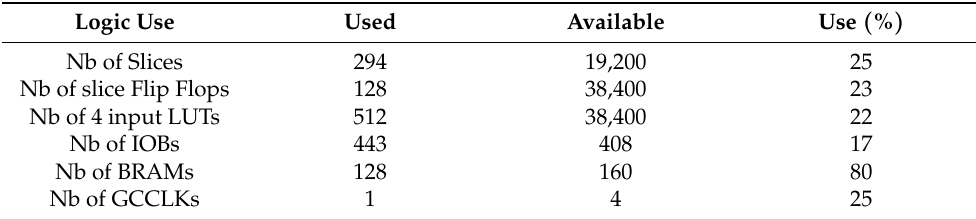
Table 4. Hardware resource utilization of the design (Dual Port Ram 1and 2) Logic Use Used Available